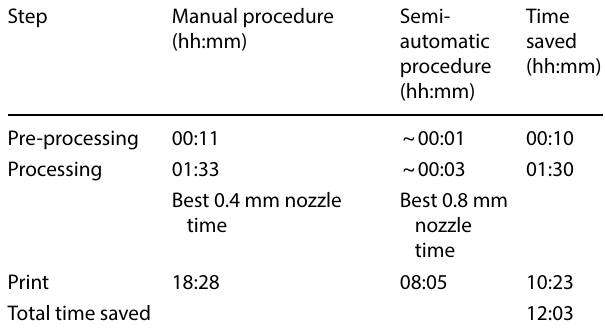
Table 4 Overall process time